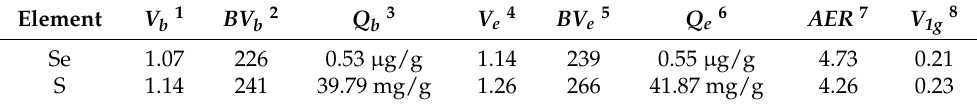
Table 1. Test results for LDH removal of Se and S from CT blowdown water in small-scale column.